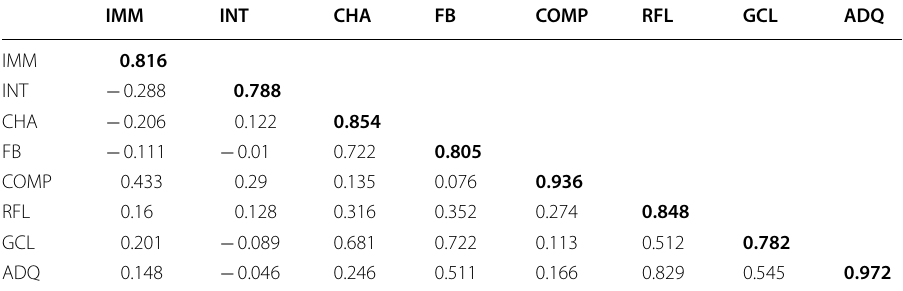
Table 4 Correlations among latent variables with AVEs